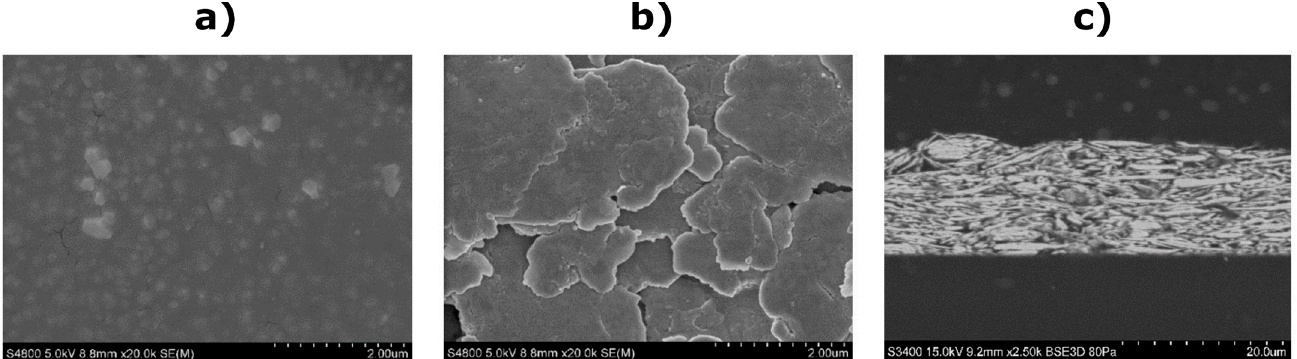
Figure 5. SEM images of the printed EMG electrode surface. ( a ) White dielectric layer (scale of 2 µm). ( b ) Silver electrode pad (scale of 2 µm). ( c ) Cross-sectional image of the printed silver electrode pad (scale of 20 µm).